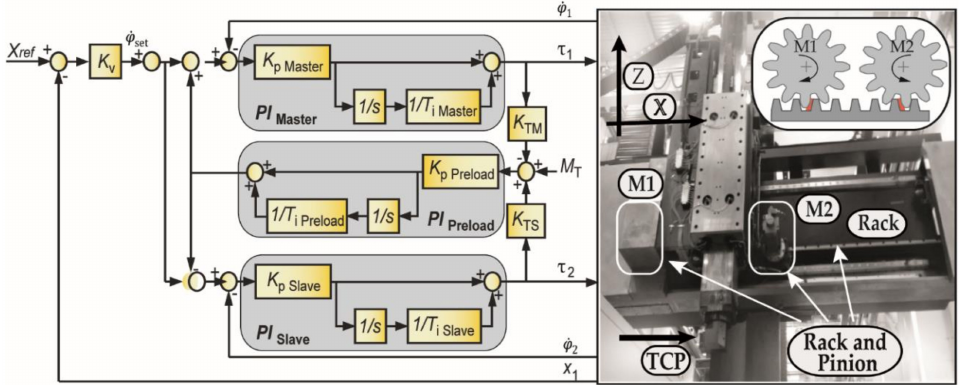
Figure 1. General Master-Slave configuration control structure and analysed machine servo